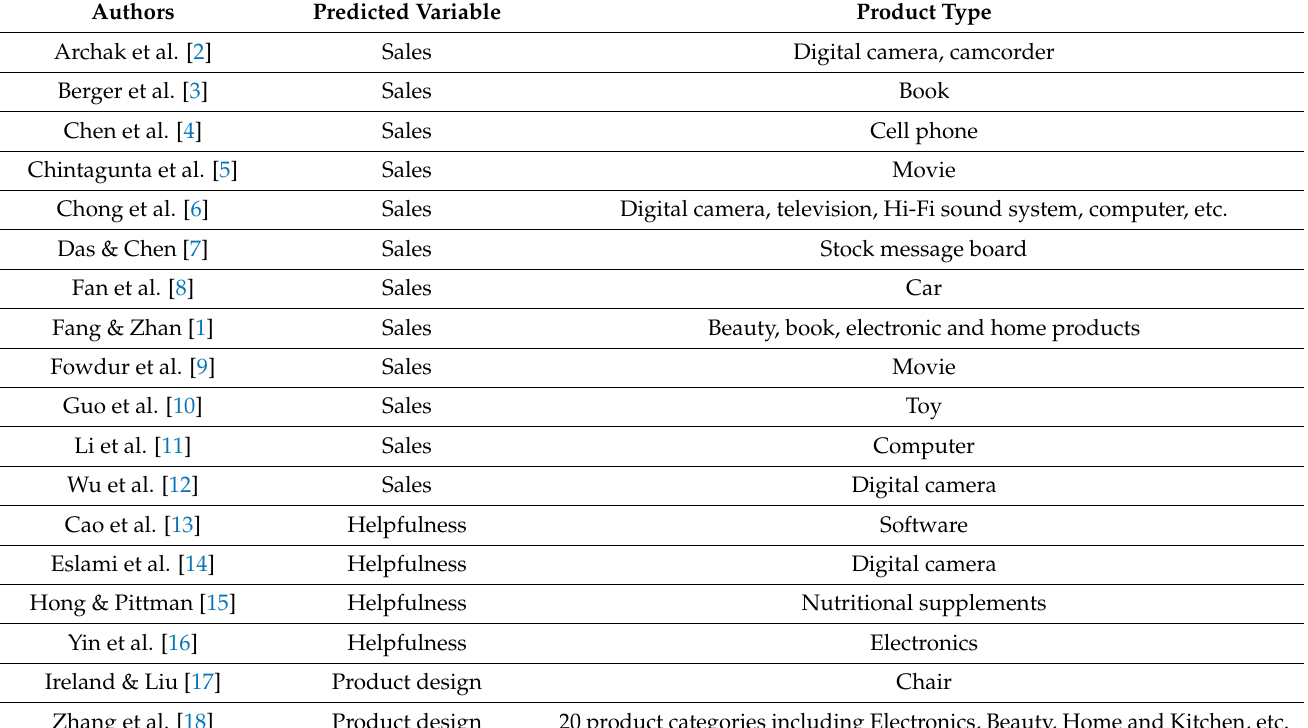
Table 1. Variables predicted by the sentiment analysis reported in the literature